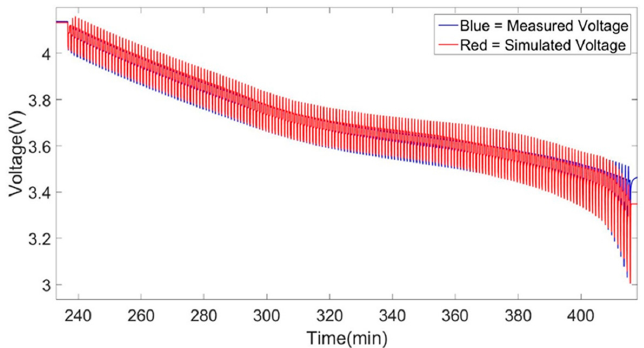
Figure 14. Error of the 1st Order Thévenin model measured and simulated DDP comparison at 25 °C with Coulomb counting and advanced characterization.